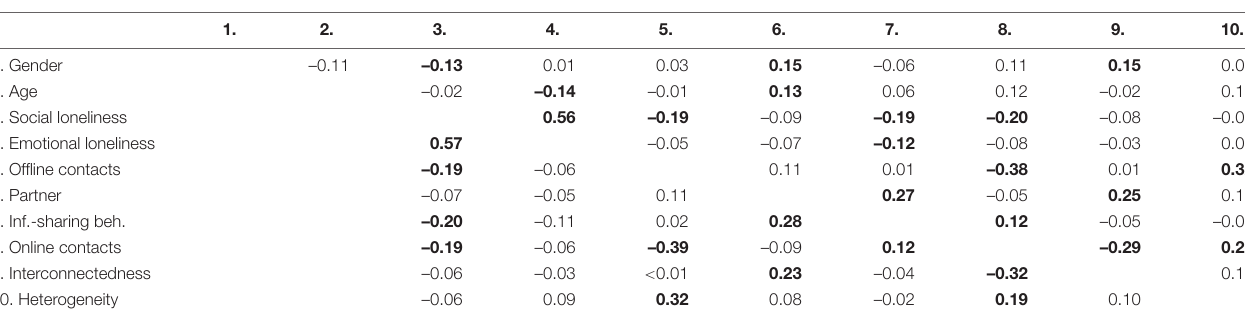
TABLE 2 | Pearson’s correlation coefficients of all variables of interest ( n =